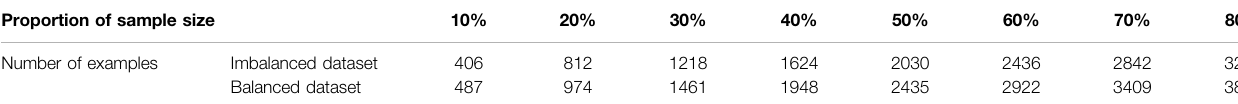
TABLE 5 | Correspondence between the proportion of sample size and the number of examples on the imbalanced dataset and the balanced dataset. Proportion of sample size 10% 20%